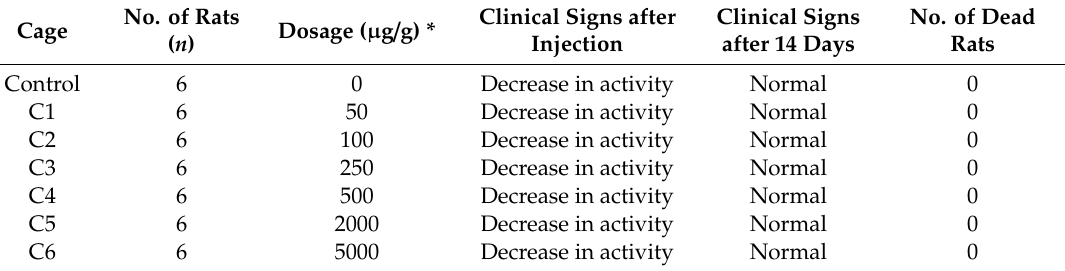
Table 4. The lethal dose (LD 50 ) study of compound 5a.